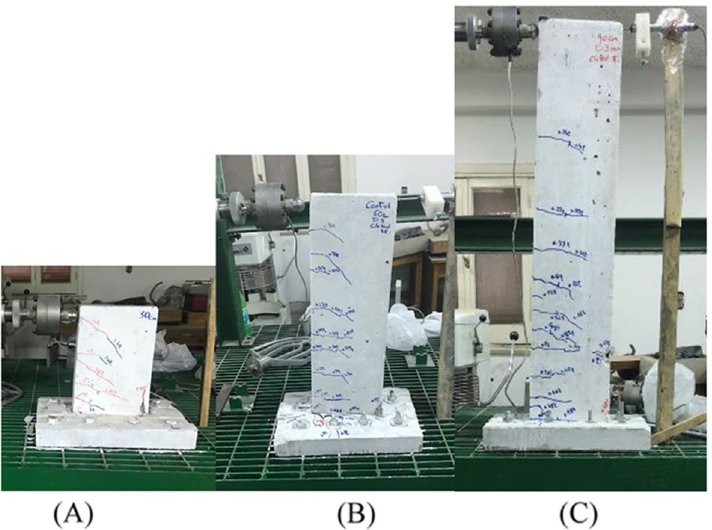
Fig. 5 Shear walls with varying aspect ratio from A R